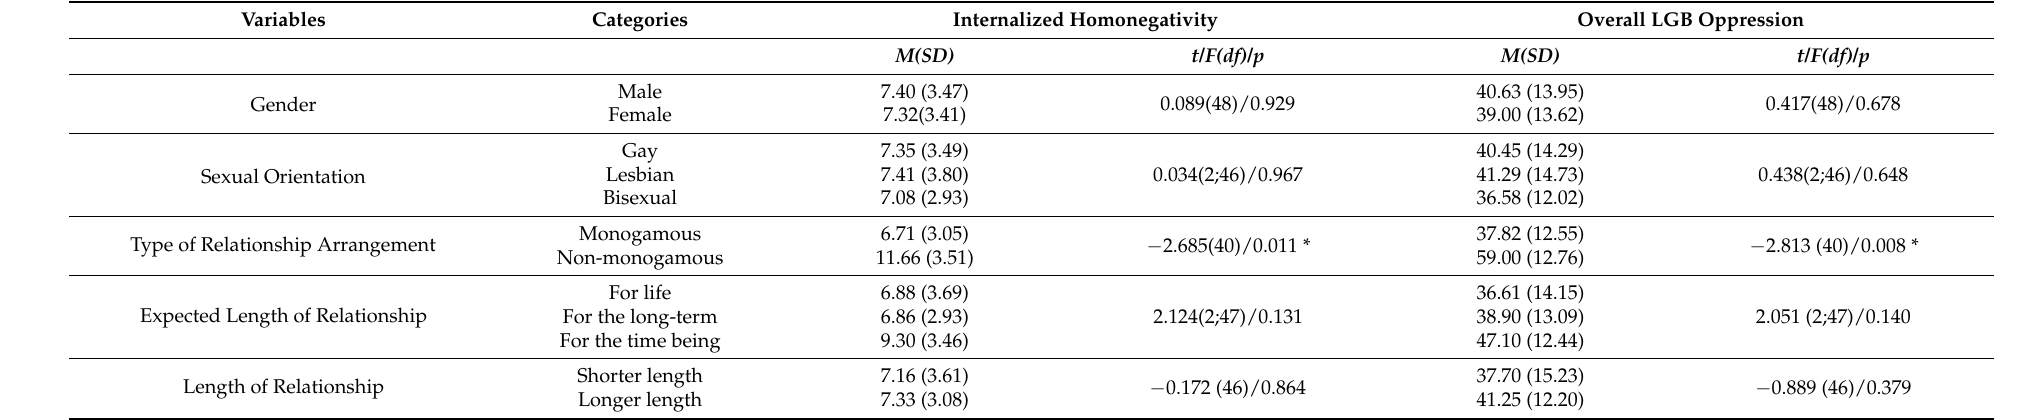
Table 5. Results for internalized homonegativity and general LGB oppression by gender, sexual orientation and relationship